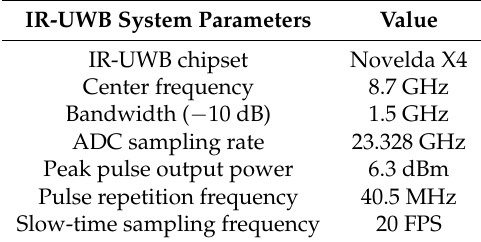
Table 1. IR-UWB Radar Features.